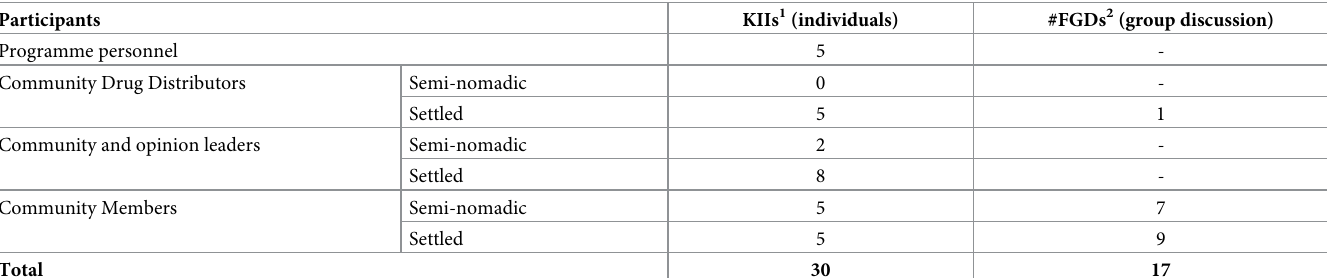
Table 1. Summary of qualitative evaluation